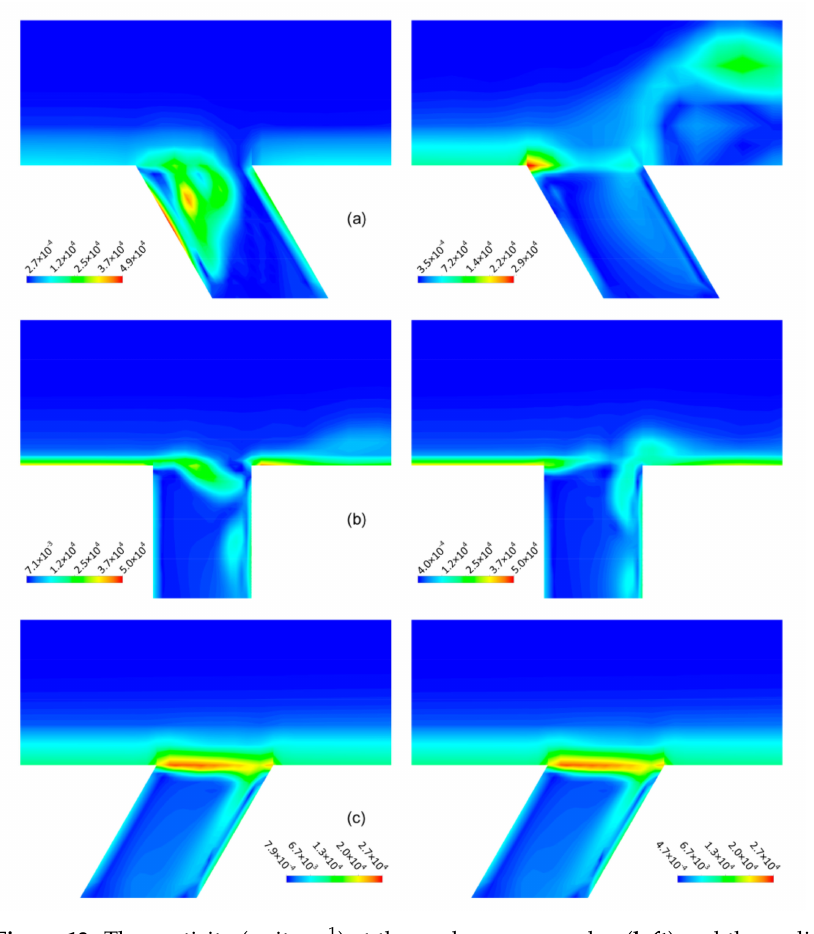
Figure 13. The vorticity (unit: s − 1 ) at the peak pressure value ( left ) and the nadir pressure value ( right ) of α = 60 ◦ ( a ), α = 90 ◦ ( b ) and α = 120 ◦ ( c ), v = 50 m/s.